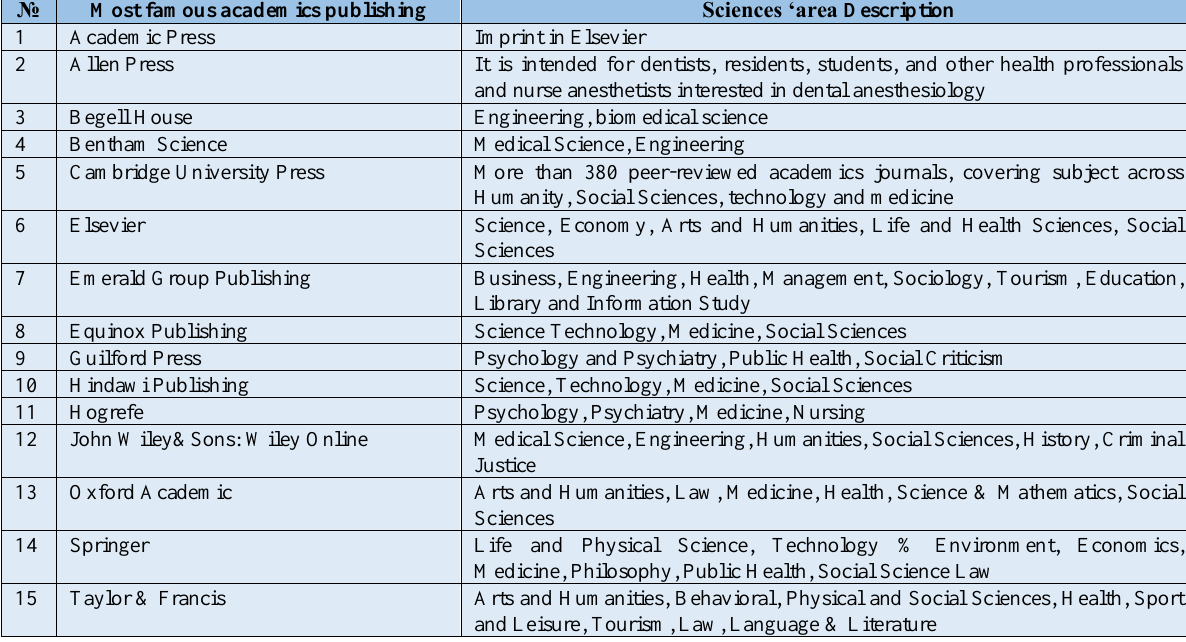
Table 3. The Most Popular Academics Publishing